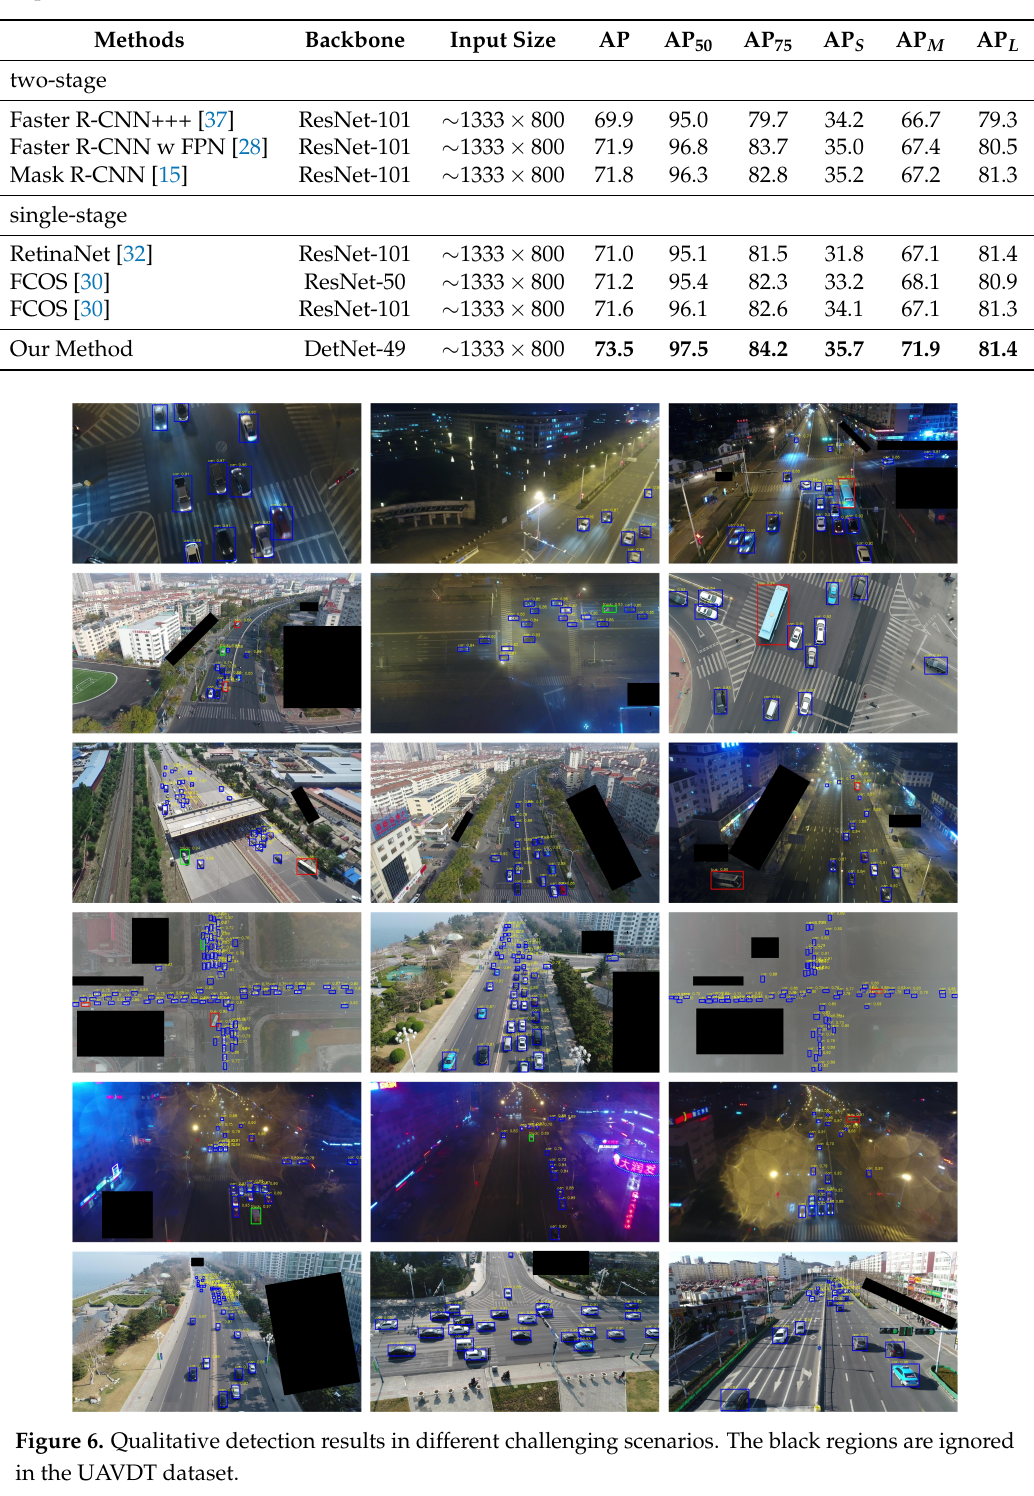
Table 4. Detection Results (%) of Different Methods for the XDUAV Dataset. The bold numbers represent the best results.